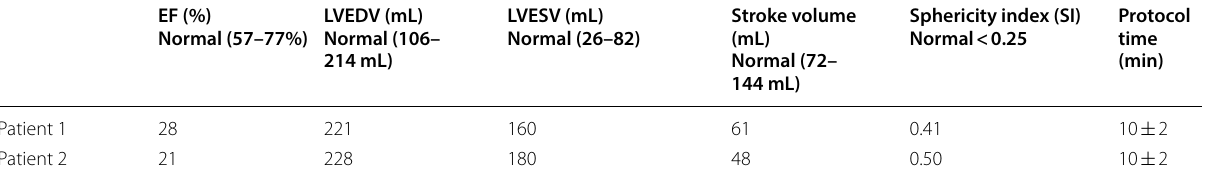
Table 1. 3DE-derived left ventricular ejection fraction, sphericity index and left ventricular volumes